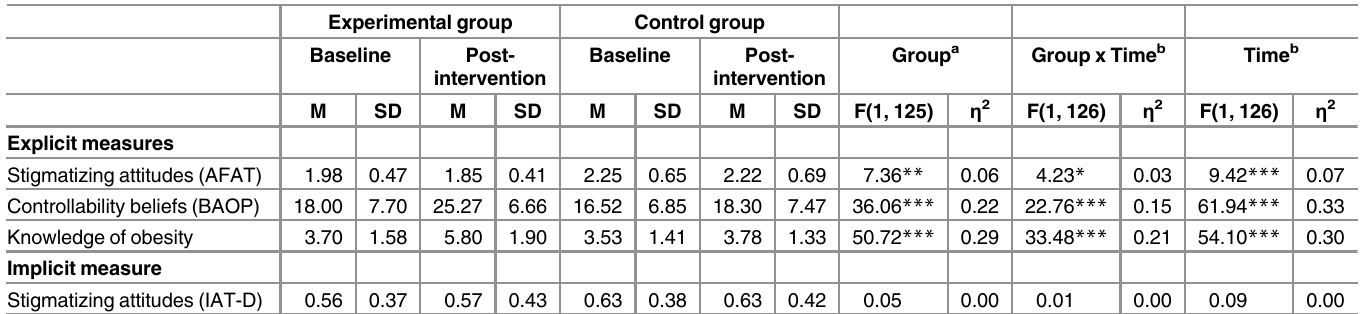
Table 1. Study 1: Effects of a brief interactive stigma reduction intervention over two weeks in a student sample (N =